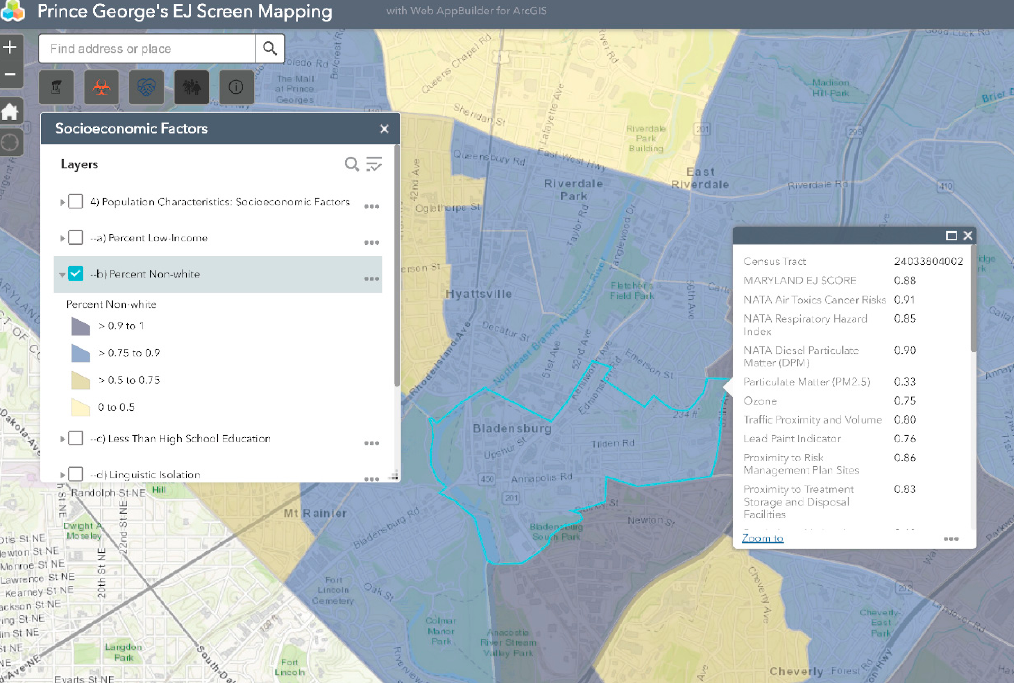
Figure 4. Percent non-White in Bladensburg. This map highlights the rate of percent non-White individuals in Bladensburg, MD.